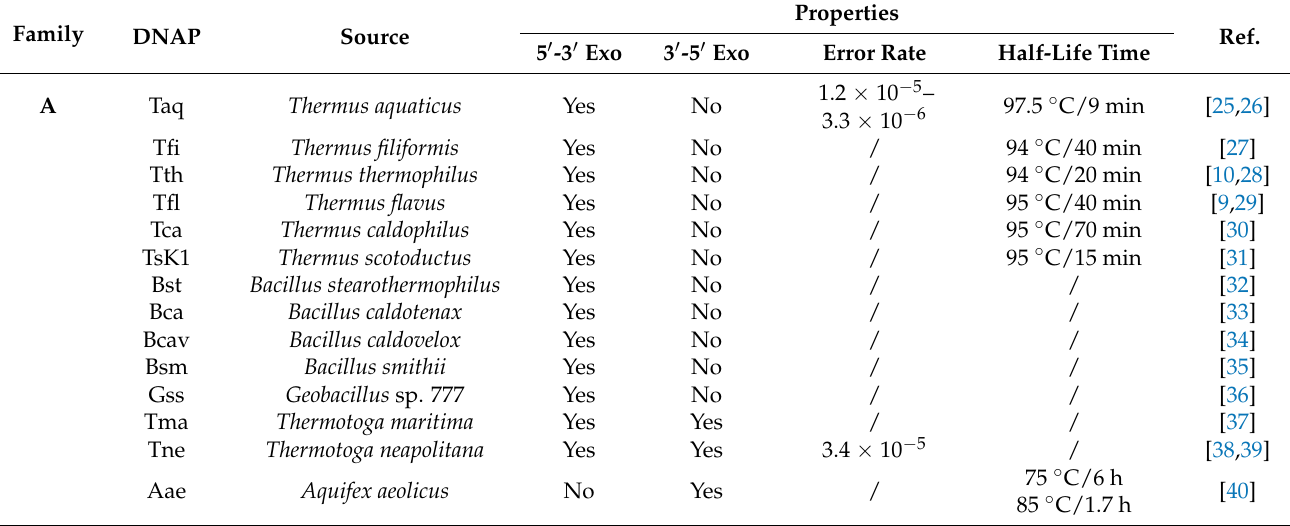
Table 1. Representative thermophilic and hyperthermophilic DNAPs. Family